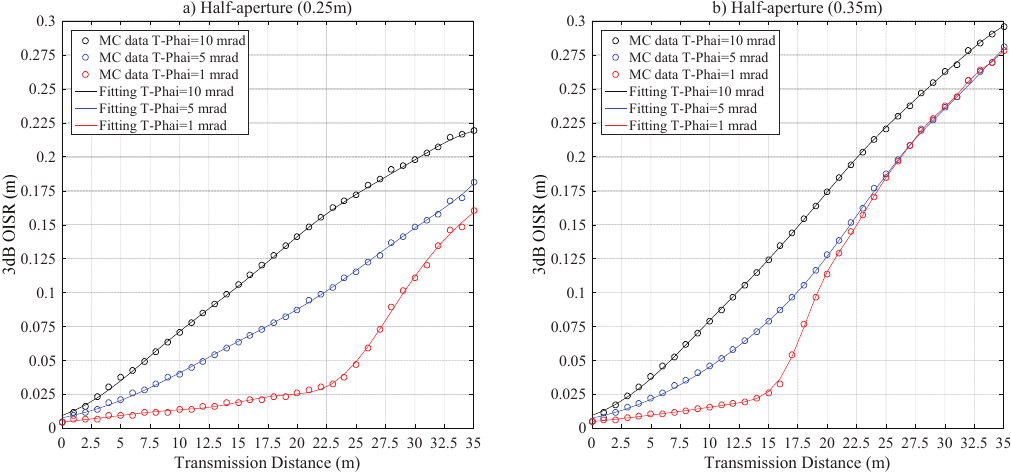
Figure 11. The r 3 dB versus Z 0 for coastal seawater laser channel for a half-aperture of ( a ) R PD = 0.25 m and ( b ) R PD = 0.35 m.